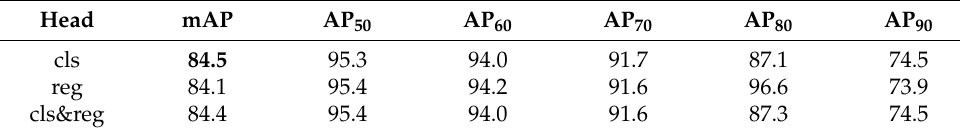
Table 4. Comparison between three types of head to attach OPCL.